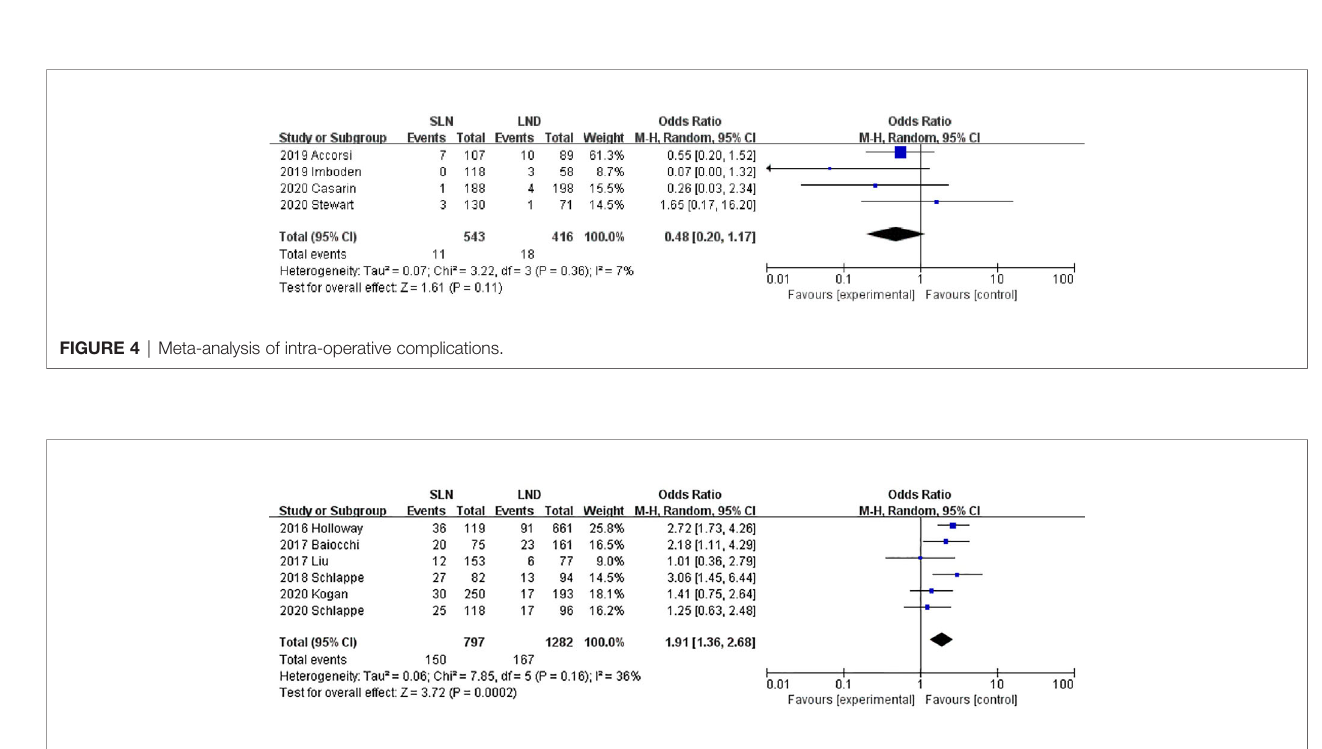
FIGURE 5 | Meta-analysis of pelvic lymph nodes positive.